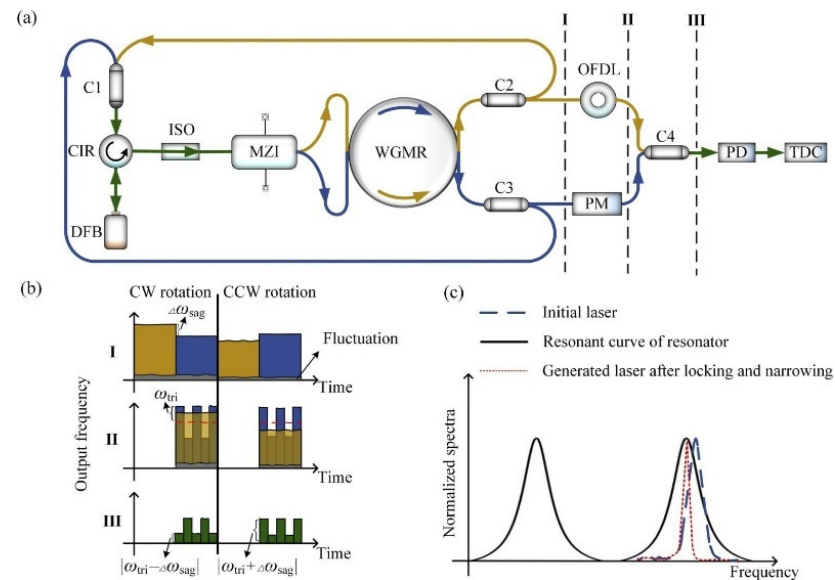
Figure 21. Configuration of RIOG. ( a ) The configuration of RIOG with the self-injection locking